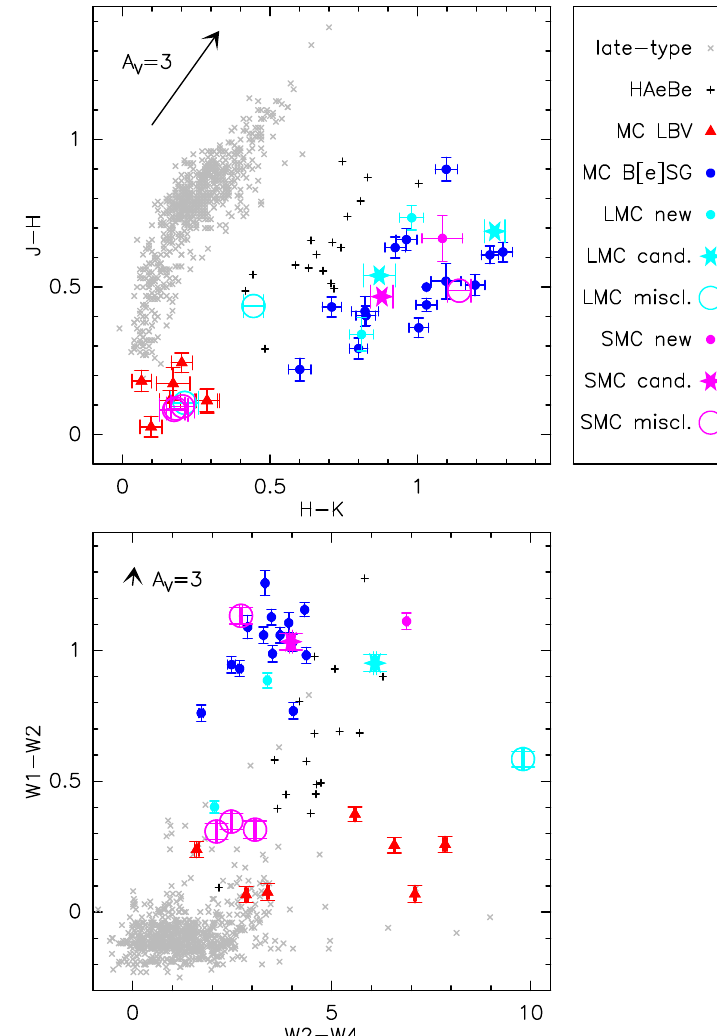
Figure 6. Location of the new LMC (light blue) and SMC (purple) samples with respect to those MC B[e]SGs that meet all the required classification criteria (dark blue) and LBVs (red triangles) in the near-IR ( top ) and the WISE diagram ( bottom ). Filled circles are used for confirmed B[e]SGs, filled stars for candidates, and empty circles for misclassified objects. A sample of late-type stars and supergiants in the MCs (small gray crosses, from [115]) and a sample of (dereddened, see text) Galactic HAeBe stars (black plus signs, from [116]) are also included. The arrow in each panel indicates the direction of the reddening, and their length complies with a value of A V = 3. As the color excess is not known for all MC objects, no extinction correction has been applied. However, the MC stars have in general relatively small color excess values (see Tables4 and 5), which would shift them only marginally in the